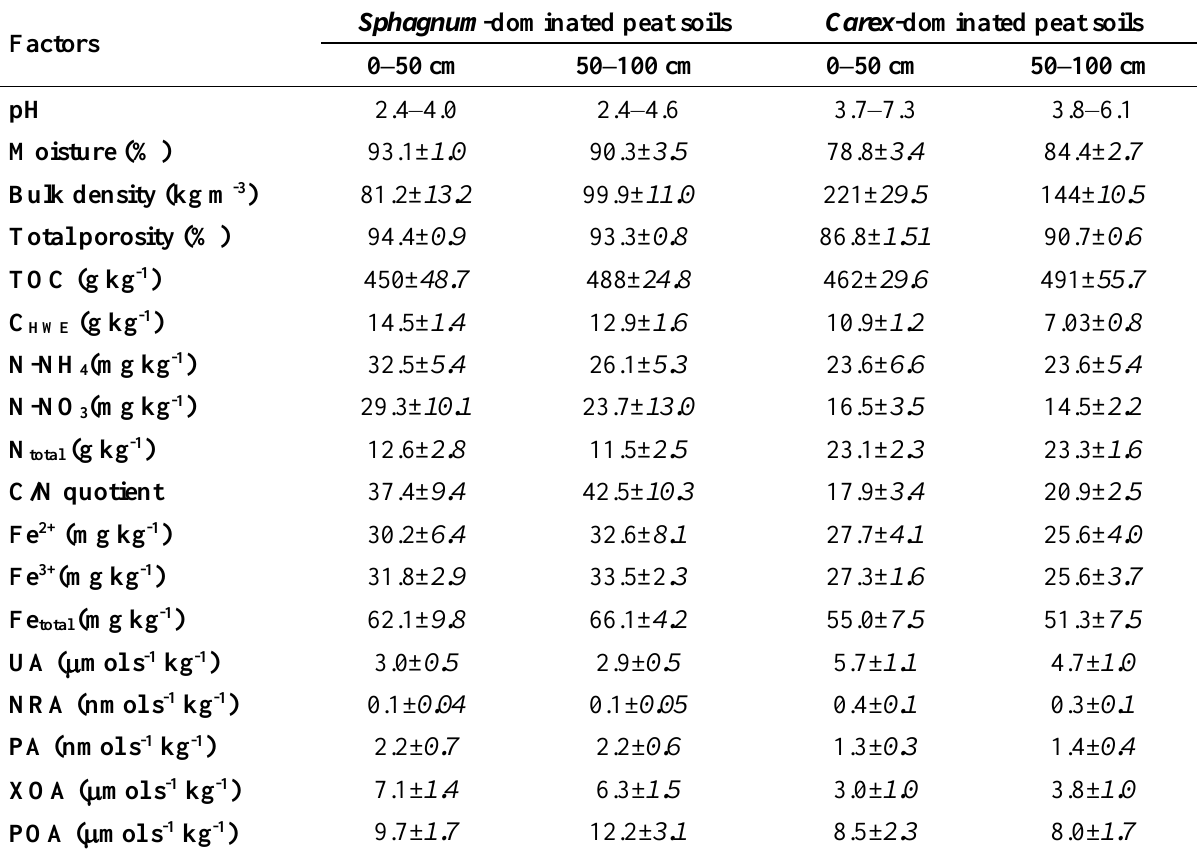
Table 2. Mean contents of chemical compounds, physical factors and enzyme activities in 0–50 cm and 50– 100 cm layers of studied soils (n = 9 for Sphagnum layer 0–50 cm, n = 8 for Sphagnum layer 50–100 cm, n = 10 for Carex layer 0–50 cm, n = 11 for Carex layer 50–100 cm). C hot water extractable organic carbon, HWE = N total nitrogen, NRA = nitrate reductase activity, PA = peroxidase activity, POA = phenol oxidase activity, total = TOC = total organic carbon, UA = urease activity, XOA = xanthine oxidase activity, x ±Δ x = confidence interval of average at confidence level  = 0.05 for n-1 degrees of